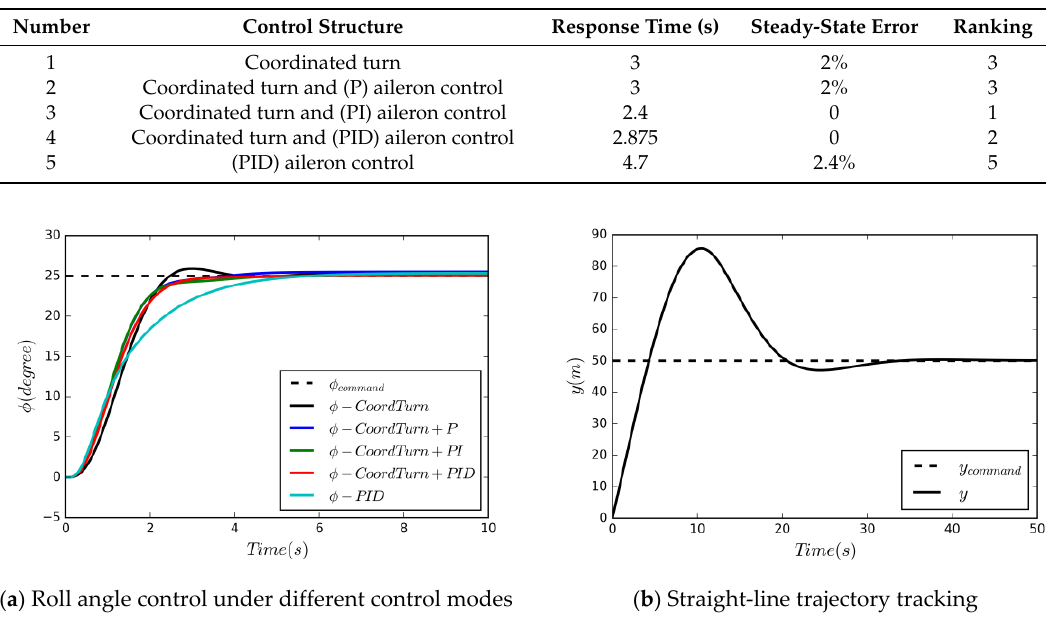
Figure 9. Roll angle hold comparison and straight-line path tracking.